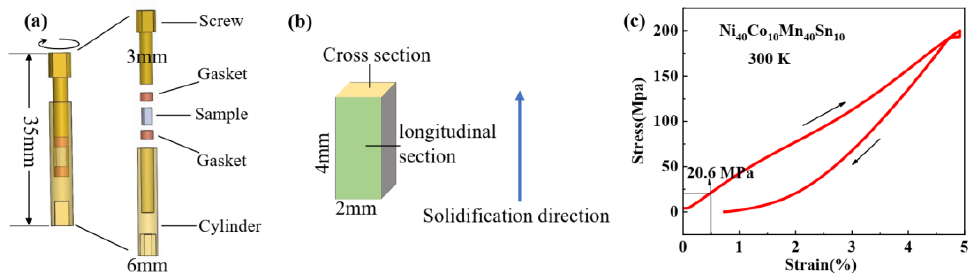
Figure 1. ( a ) The overall and exploded schematic diagram of a home-built uniaxial strain pressure cell, where the dimensions and descriptions of each part are marked. ( b ) Schematic of the NCMS sample, where its size and direction are marked. ( c ) Compressive stress-strain curves (red line) measured with a low strain rate of 1.3 × 10 − 4 s − 1 at 300 K and the arrows indicate the loading and unloading process.